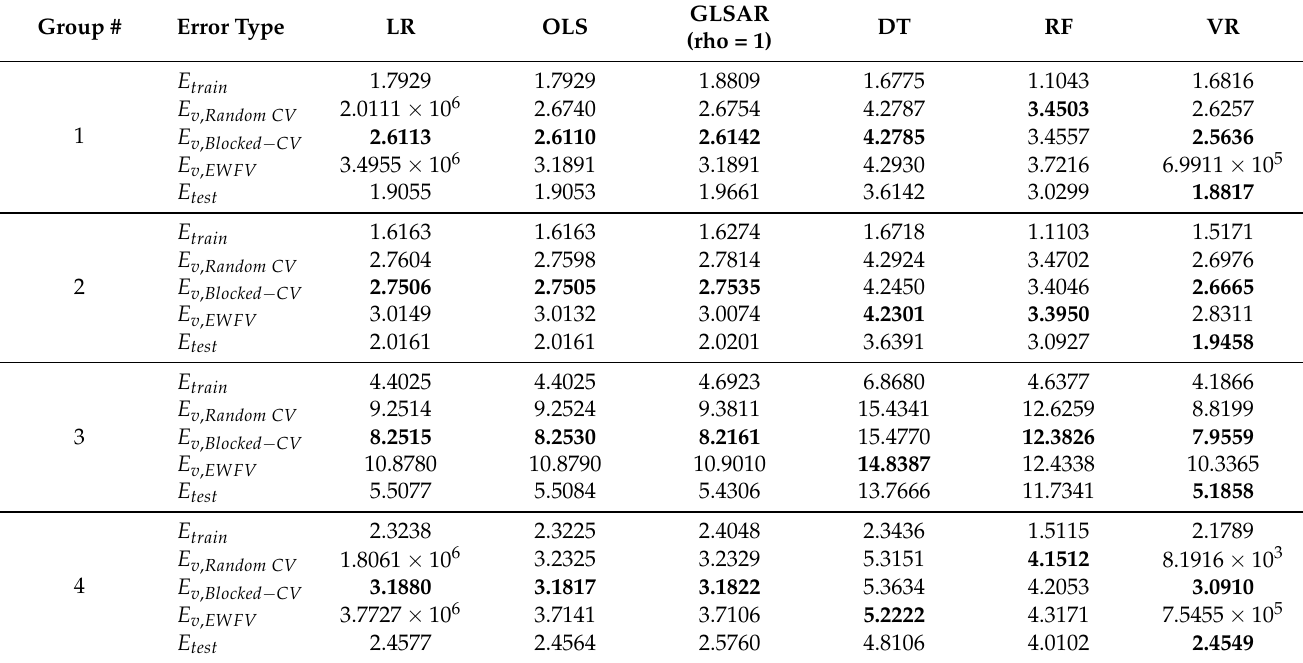
Table 4. Training, validation, and test MAPE values (in %) for all groups.